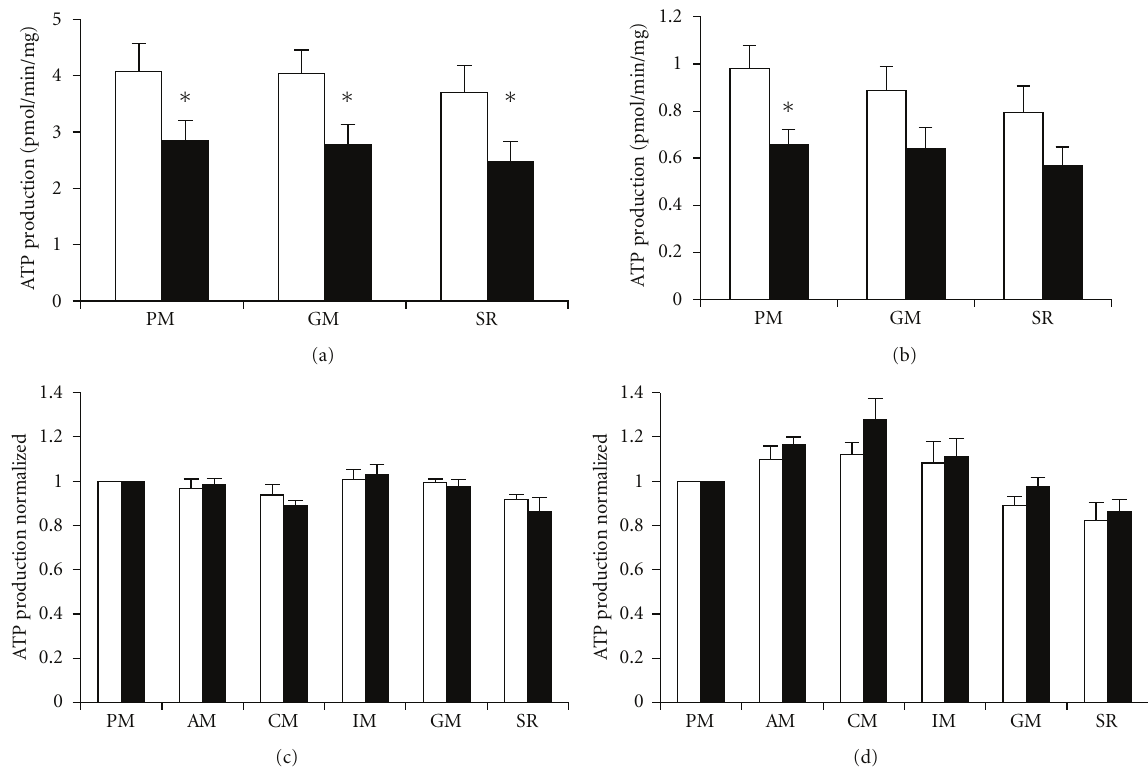
Figure 1: Rates of ATP synthesis in isolated mitochondria. The ATP synthesis rate was determined in isolated mitochondria of di ff erentiated myotubes established from lean (open bars) and type 2 diabetic subjects (black bars). Isolated mitochondria were incubated with various substrates as indicated, supplemented with/without hexokinase as described in Section 2. (a) shows ATP synthesis in isolated mitochondria without hexokinase treatment. ∗ P < 0 . 05 versus control. (b) shows ATP synthesis in isolated mitochondria with hexokinase treatment. ∗ P < 0 . 05 versus control. (c) shows normalised ATP synthesis rates without hexokinase treatment. (d) shows normalised ATP synthesis rates with hexokinase treatment. Data are means ± SE, n = 8 in each group. acetate (A), citrate (C), isocitrate (I), glutamate (G), malate (M), pyruvate (P), rotenone (R), and succinate